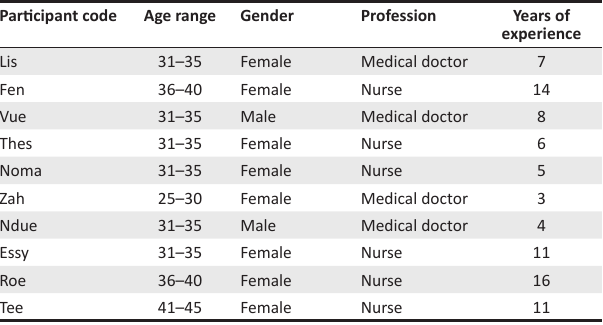
TABLE 2: An example of the data analysis